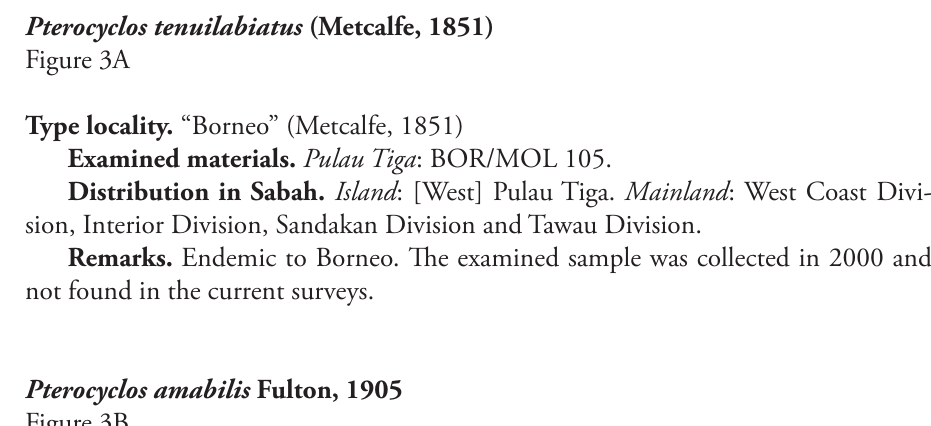
Figure 3B Type locality. “N. Borneo” (Fulton, 1905) Examined materials. Pulau Gaya : BOR/MOL 8850, BOR/MOL